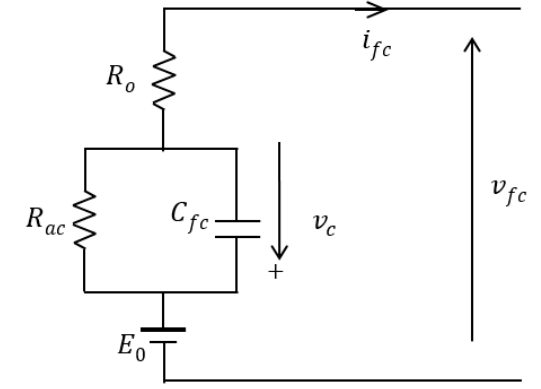
Figure 4. Equivalent electric RC circuit of a fuel cell stack.